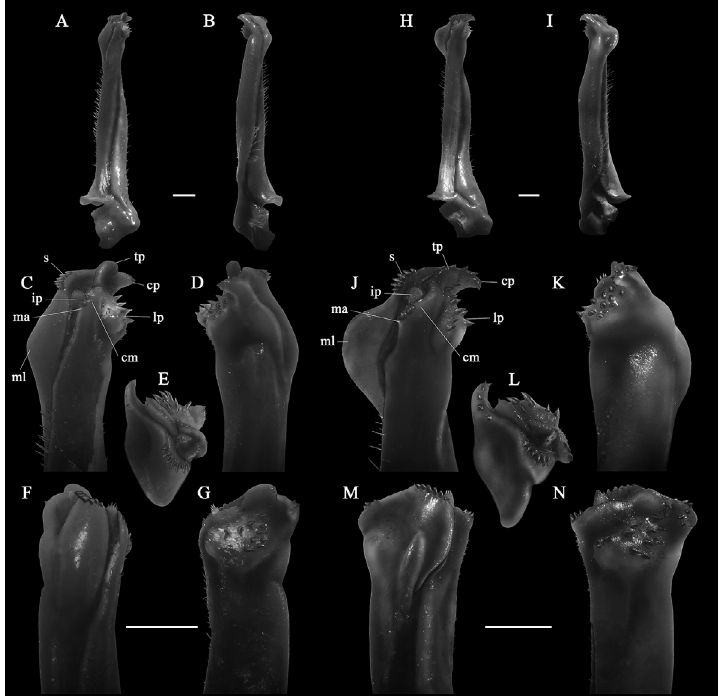
Figure 6. Right first gonopod of an adult male of Epilobocera capolongoi (CZACC 5.0047) ( A – G ) and E. cubensis (CZACC 5.0050) ( H – N ) from Lomas de Banao Ecological Reserve. A , H , whole structure, cephalic view; B , I , whole structure, caudo-mesial view; C , J , distal portion, cephalic view; D , K , distal portion, caudal view; E , L , distal portion, apical view; F , M , distal portion, mesial view; G , N , distal portion, lateral view. Abbreviations: Mesial lobe (ml), intermediate plate (ip), spines of mesial process (s), terminal process (tp), caudal process (cp), lateral process (lp), cephalic margin (cm), mesial angle of cephalic margin (ma). Scale bars = 1